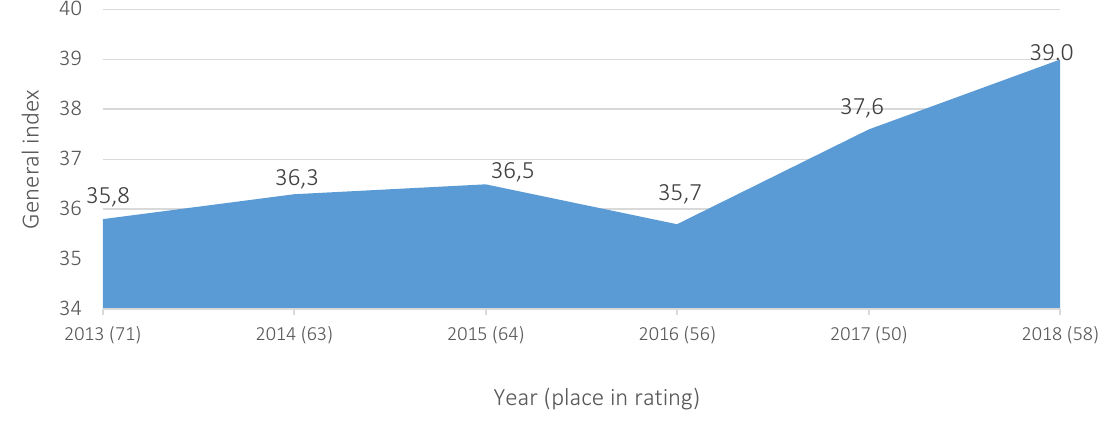
Figure 1. Dynamics of the Global Innovation Index and place of Ukraine